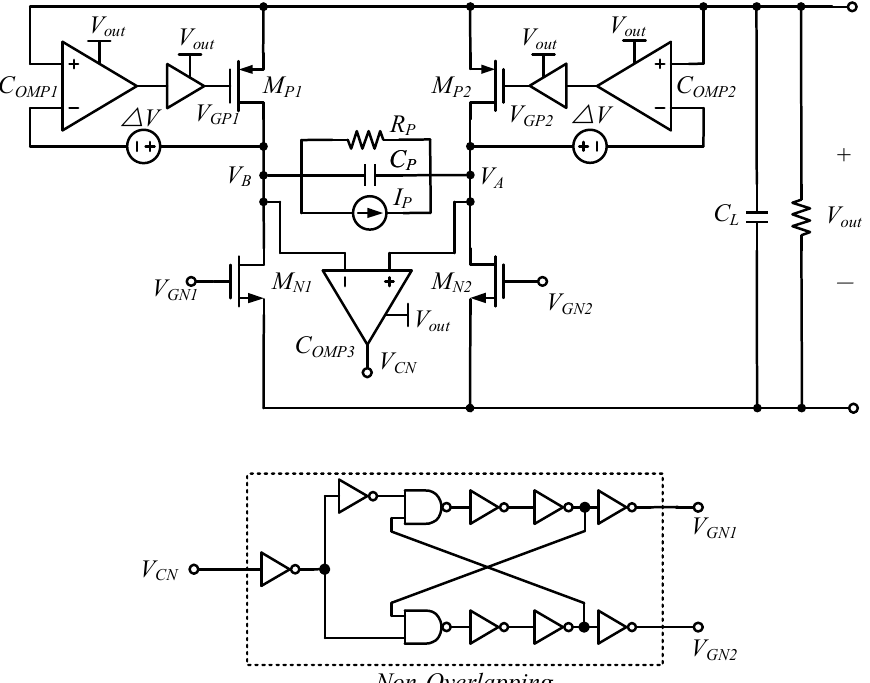
Figure 9. Active rectifier with non-overlapping control.